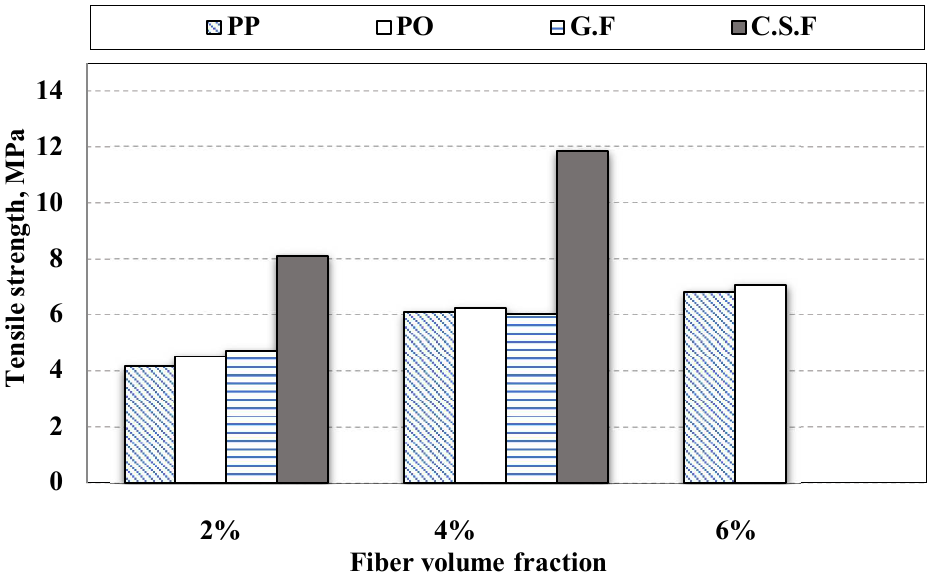
Figure 10. Splitting tensile strength at 28 days due to fiber type change.